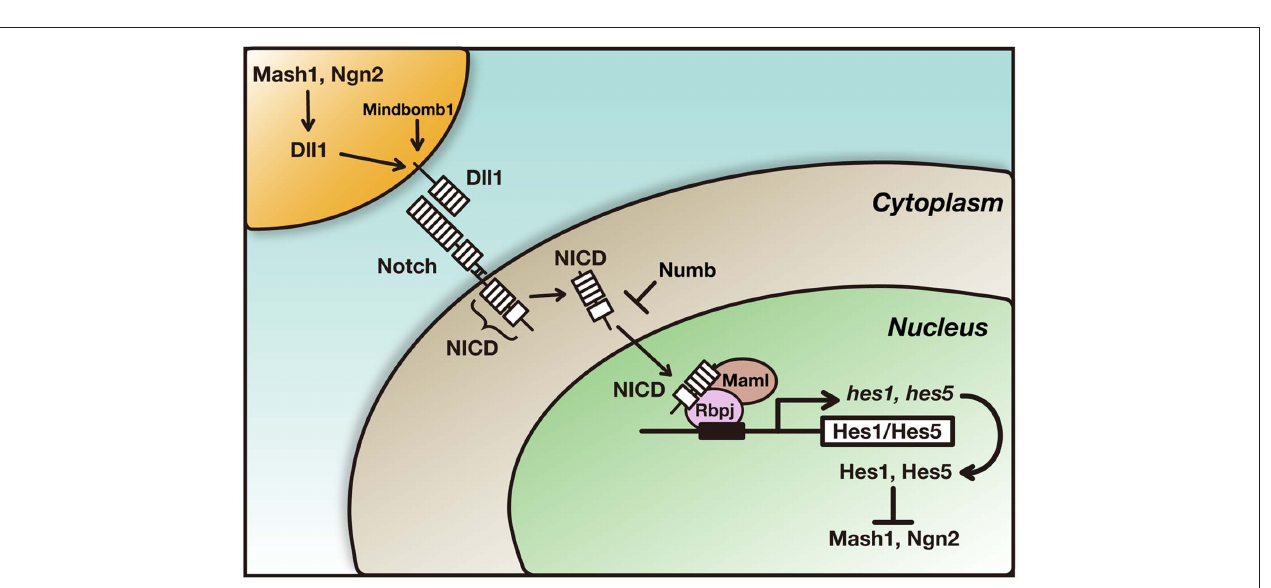
protein Rbpj and the transcriptional co-activator Maml. The NICD–Rbpj–Maml complex induces the expression of transcriptional repressor genes such as Hes1 and Hes5 . Hes1 and Hes5 then repress the expression of proneural genes and Dll1, thereby leading to the maintenance of neural stem/progenitor cells. Numb inhibits Notch signaling and induces neuronal